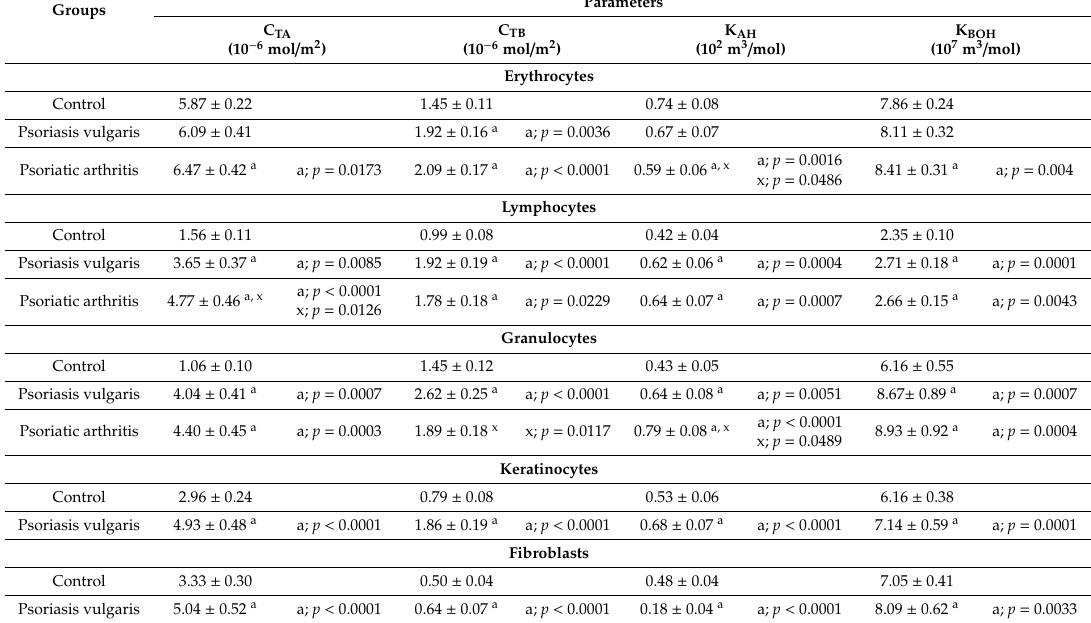
Table 3. The value of total concentrations of negatively (C TA ) and positively (C TB ) charged groups and their association constants with H + (K AH ), and OH - (K BOH ) ions of blood cells (erythrocytes, lymphocytes and granulocytes) as well as skin cells (keratinocytes and fibroblasts) of patients with psoriasis vulgaris ( n = 16) and psoriatic arthritis ( n = 8) as well as healthy subjects ( n = 8).